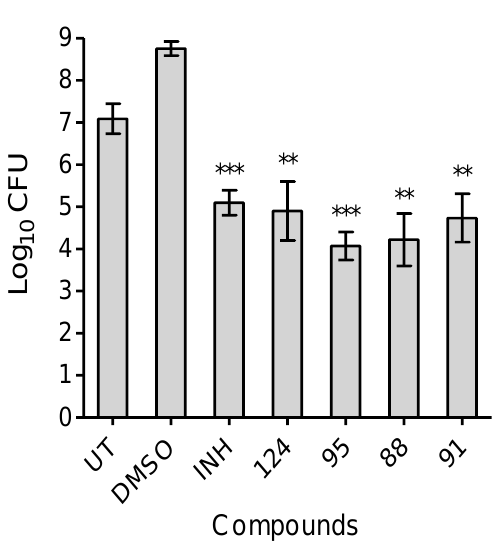
Figure 5. Time-kill kinetics of compounds 88 , 91 , 95 , 124 and isoniazid (INH) against M. tuberculosis H37Rv. Early logarithmic phase cultures of M. tuberculosis were exposed to 10 × minimal inhibitory concentrations (MIC 99 ) of the compounds and bacterial enumeration (expressed in colony-forming units (CFU)) was performed by plating 10-fold serial dilutions on MB7H11 plates at day 6 post-exposure. The data shown is mean ± S.E. of data obtained from three experiments performed in duplicates. Statistical significance with respect to DMSO treated samples is reported as ** ( p ≤ 0.01) and *** ( p ≤ 0.001). UT: